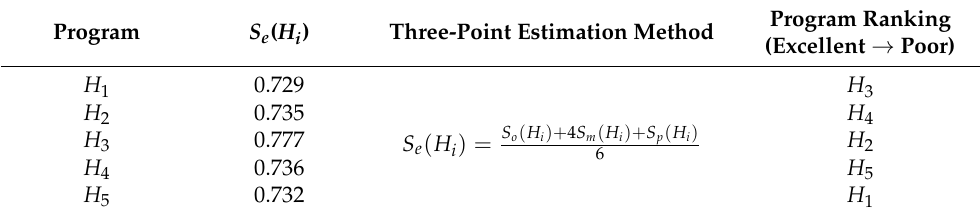
Table 3. Decision-making results and program